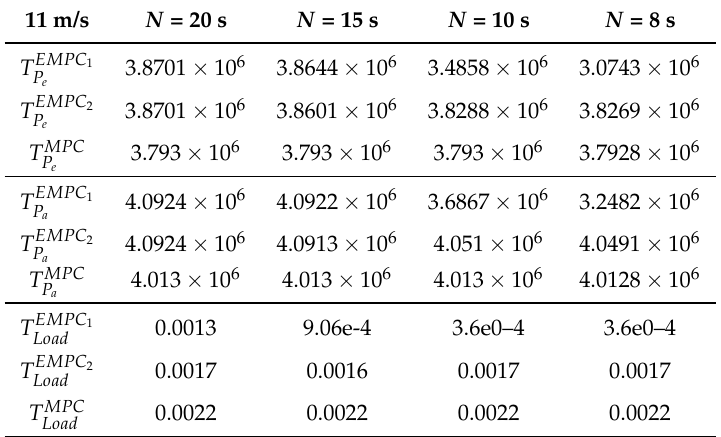
Table 5. Average economic performance for different prediction horizon at an average wind speed of 11